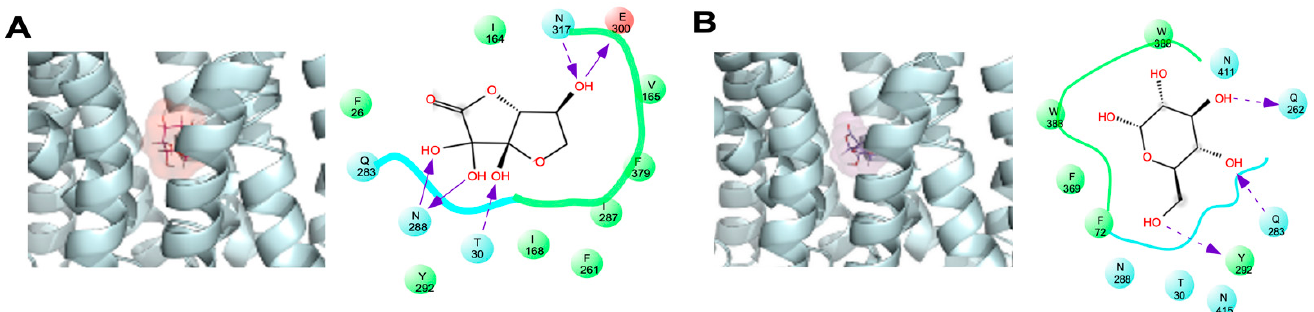
Figure 3. Comparative analysis of the DHA(bi) and glucose-binding mode of GLUT1 in the 5 Å grid. Representative complexes of GLUT1 with ( A ) DHA(bi) and ( B ) glucose are shown. The docking simulations were performed in a 5 Å grid of the GLUT1 junction pocket. Amino acid residues that interact with each molecule are indicated; the arrows indicate specific interactions between each substrate and the amino acid residues in GLUT1. Light dotted arrows indicate H-bond interactions with amino acid side chains. Negatively charged residues appear in red, hydrophobic residues in green, and uncharged polar residues in blue. Table 2. Summary of the residues that interact with glucose and DHA(bi) in the 5 Å grid of GLUT1.